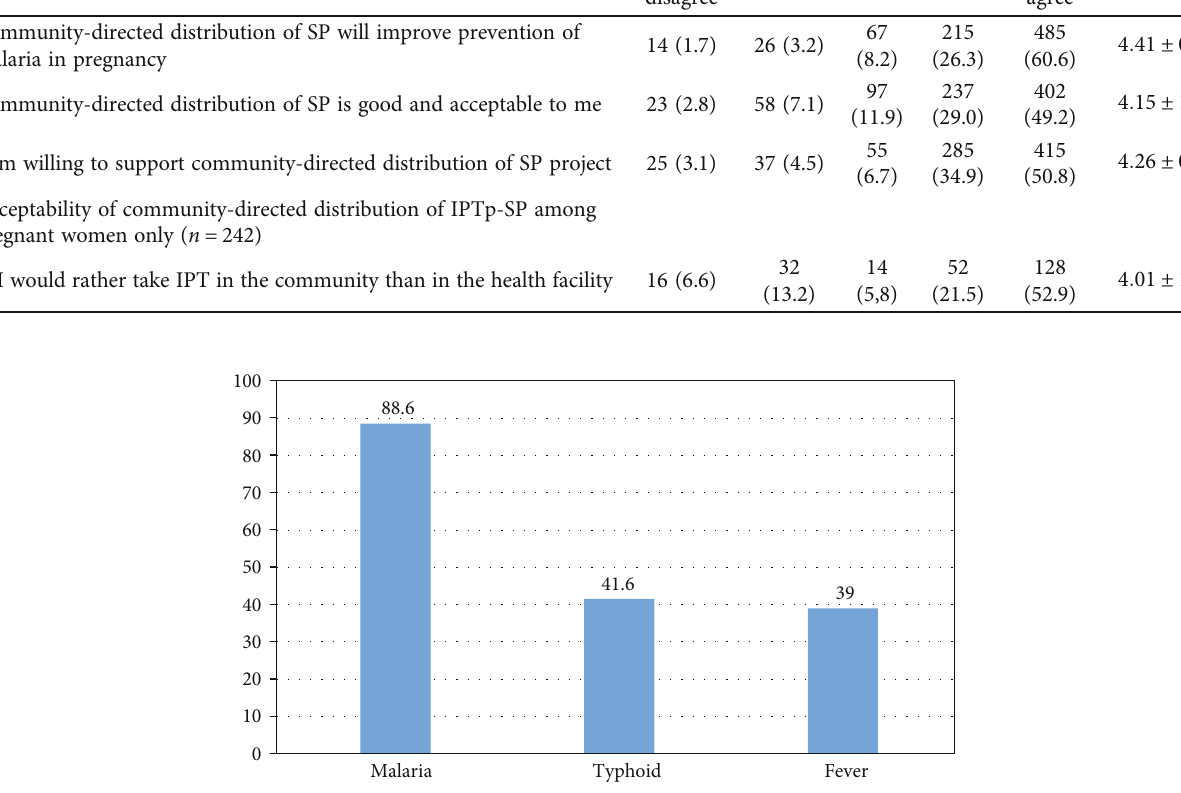
Table 6: Acceptability of community-directed distribution of IPTp-SP among community members in Ebonyi, Nigeria. Parameter assessed